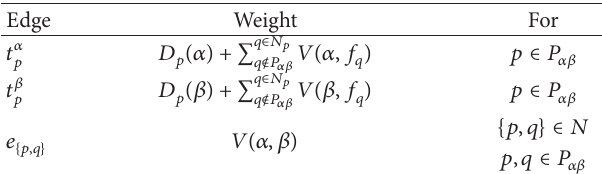
Table 1: Edge weights for graph